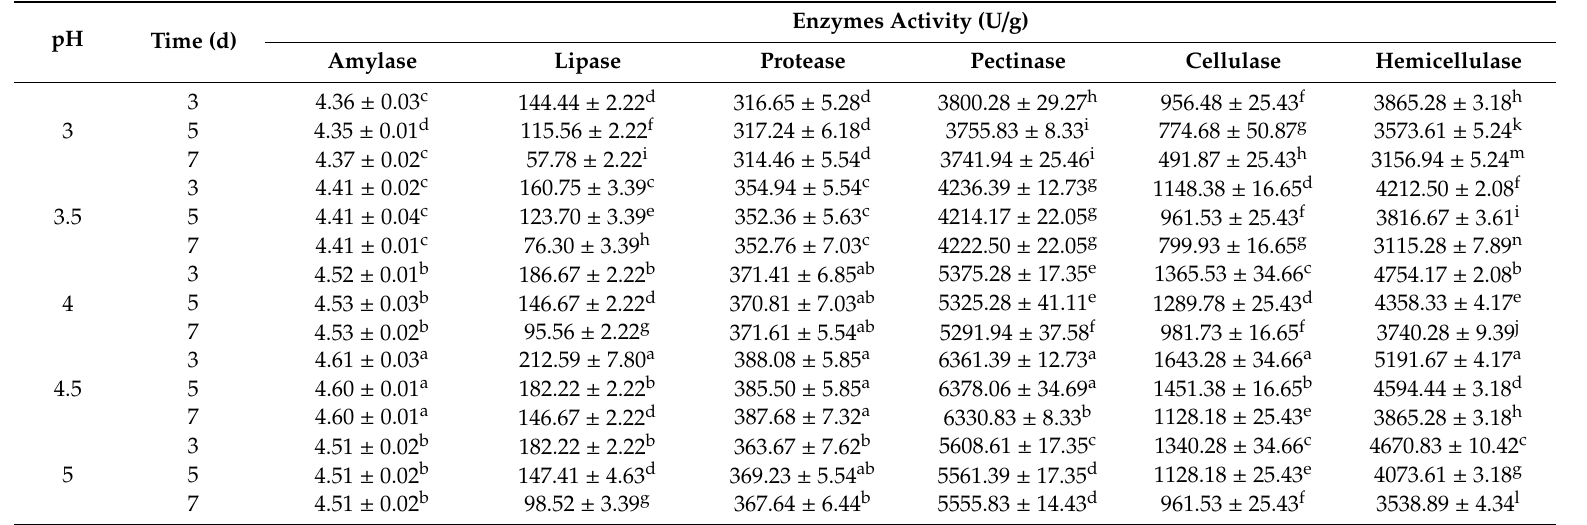
Table 4. E ff ects of pH on the activities of several enzymes in fermented G. biloba